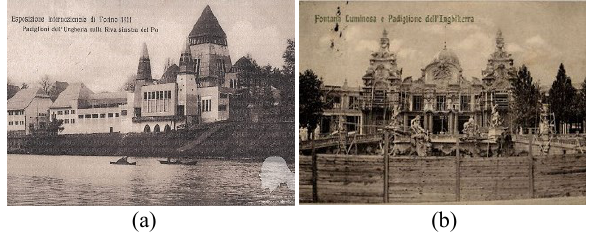
Figure 1. Hungary pavilion (a), UK pavilion (b)